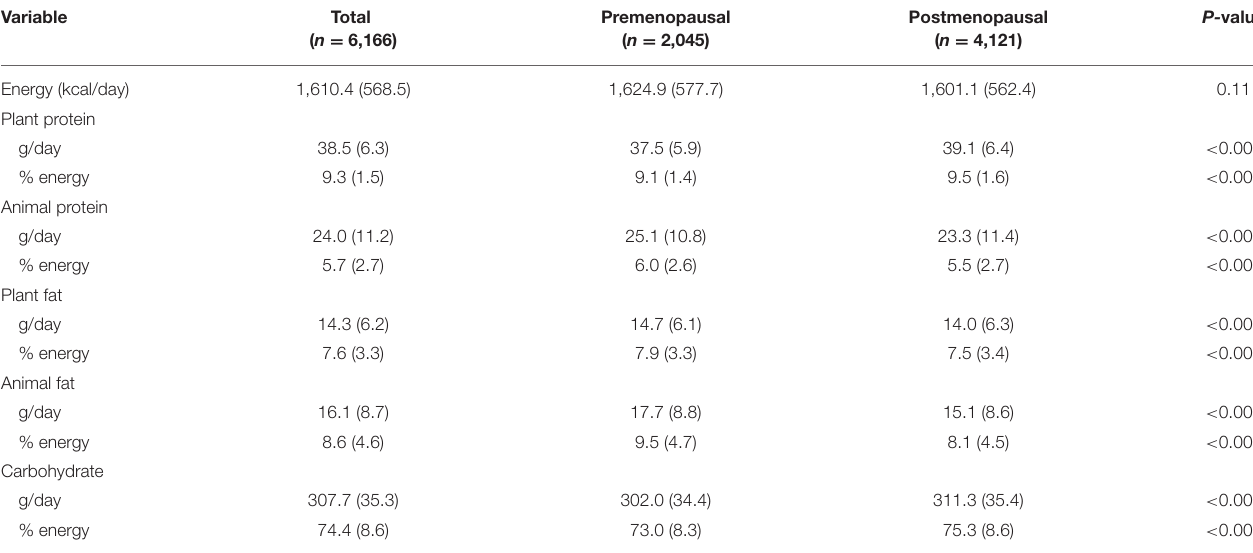
TABLE 2 | Nutrient intake in Korean women.